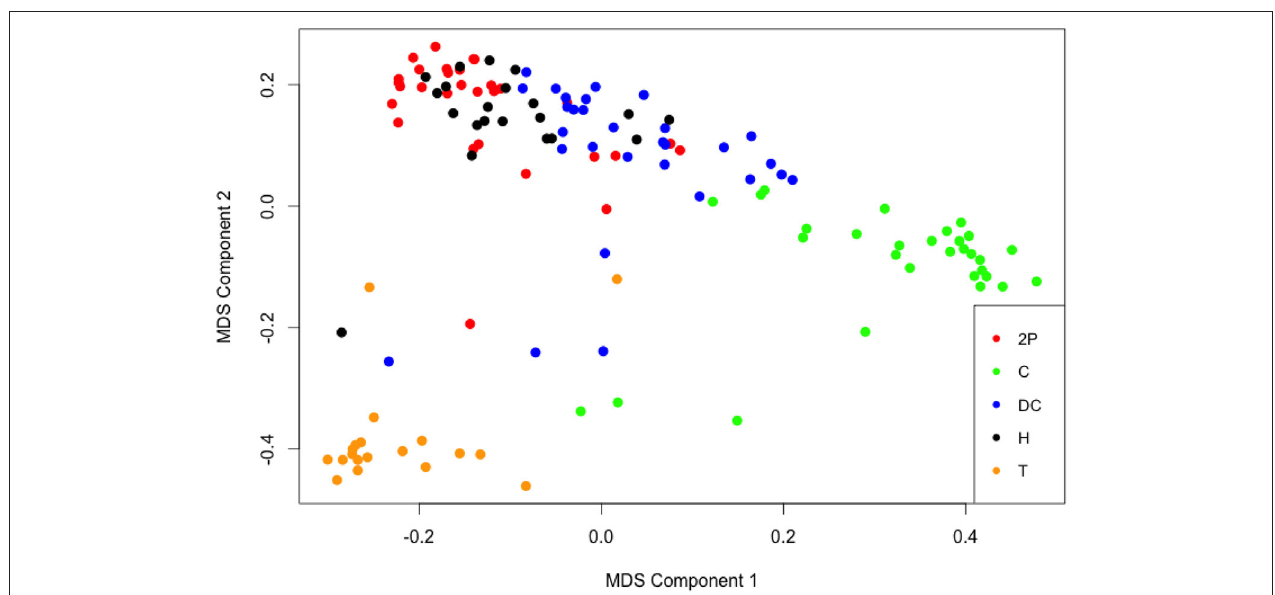
FIGURE 2 | Multi-dimensional scaling (MDS) of the proximity matrix showing Mecopoda song type clusters based on geometric morphometrics of subgenital plate and right cercus of 130 Mecopoda individuals. The different colored circles represent Mecopoda song types: 2P, Two Part; C, Chirper; DC, Double Chirper; H, Helicopter; T,